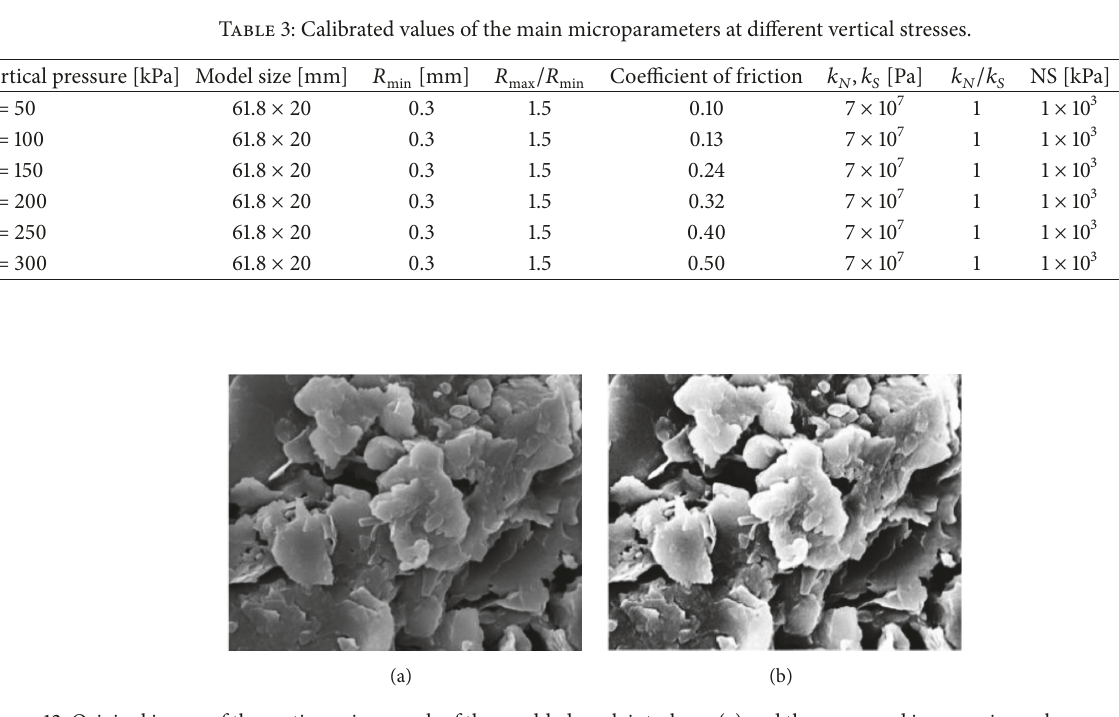
Figure 12: Original image of the section micrograph of the mudded weak interlayer (a) and the processed image using enhancement domain methods (b).